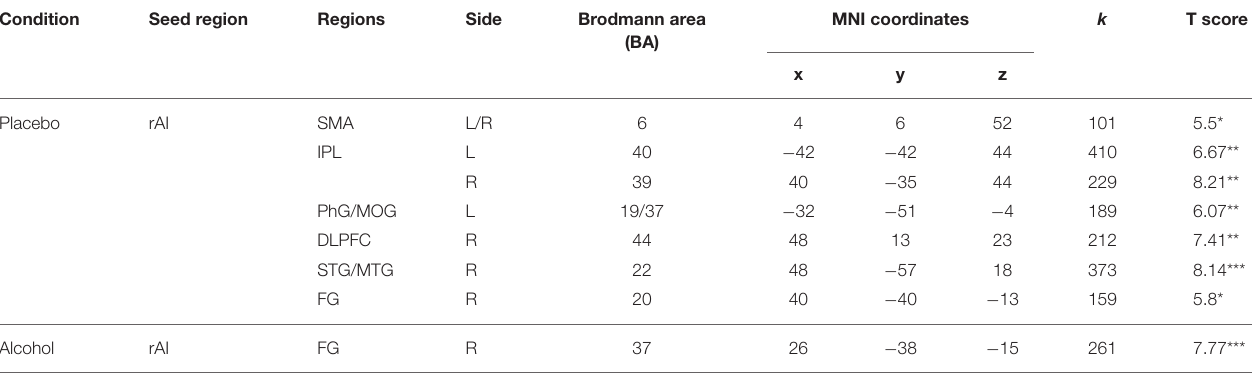
TABLE 5 | Increased PPIs of the seed region during empathy for pain in the placebo and alcohol conditions ( p < 0.001; k = 100). Condition Seed region Regions Side Brodmann area